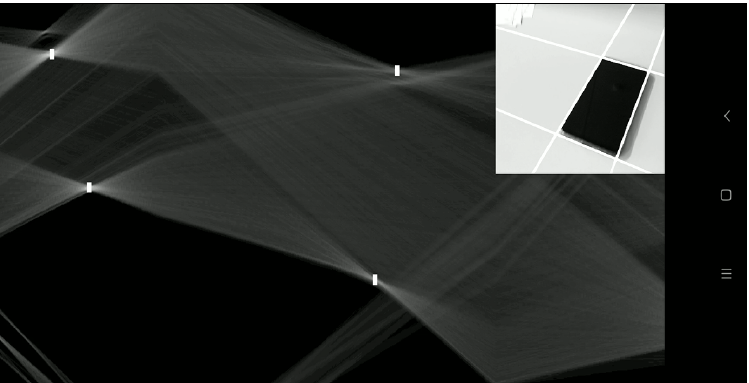
Figure 20. Screen recording of a smart-phone executing the demonstrative application. The camera input is shown on the top-left corner. The rest of the image is the output of the central DRT of the gradient magnitude. Four maxima are highlighted and back-projected to image